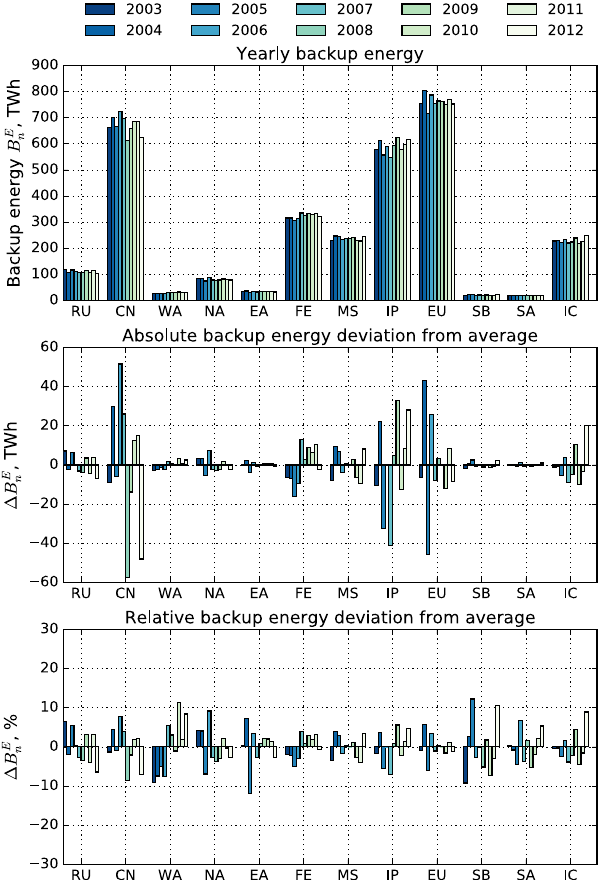
Figure 4. Yearly backup energy need and its deviation from 10-year average (cid:49)B C n = (cid:104) B C n (cid:105)− B C n for the isolated regions with α = 1.